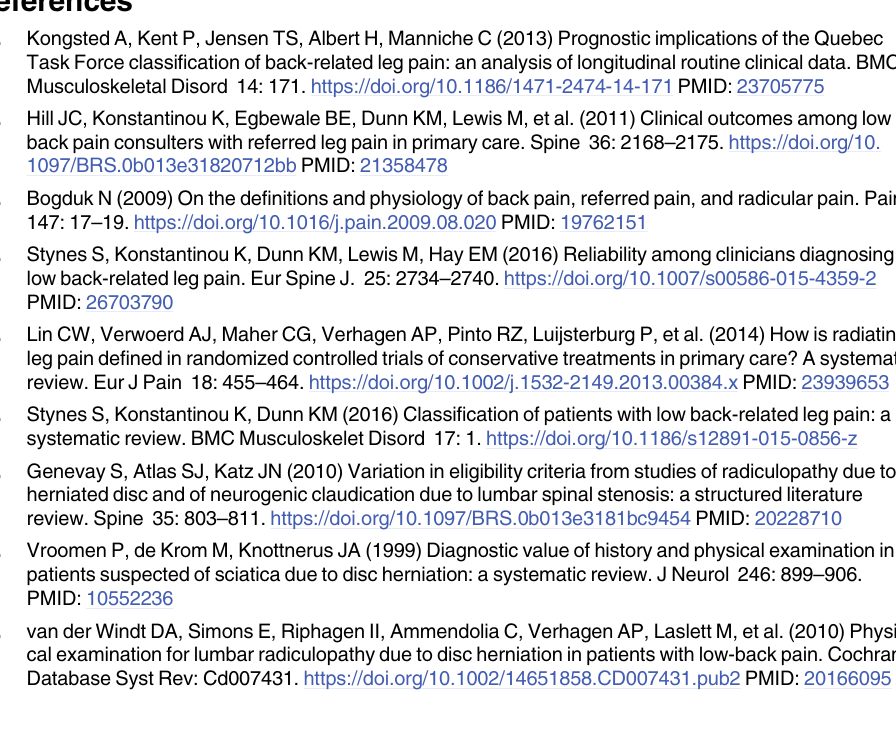
S1 Table. Predictor selection and their measurement